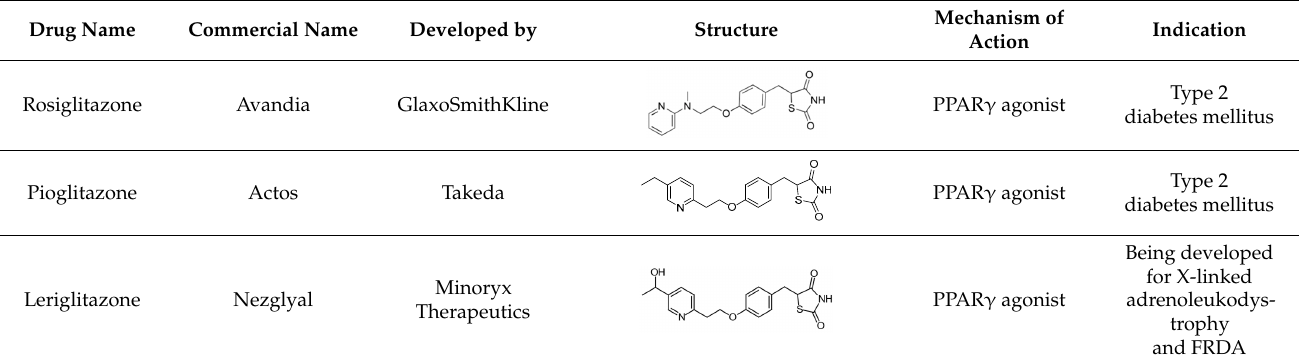
Table 1. PPAR γ agonist thiazolidinedione drugs marketed or actively in development.